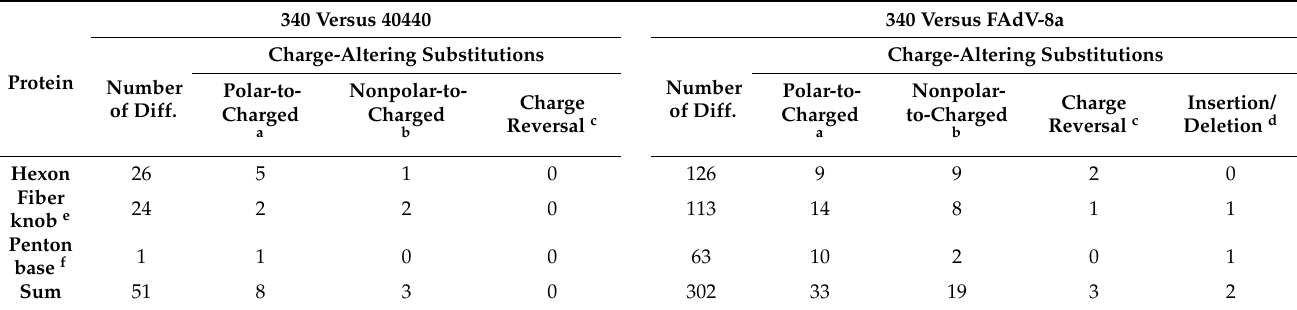
Table 5. Amino acid substitutions of the major capsid